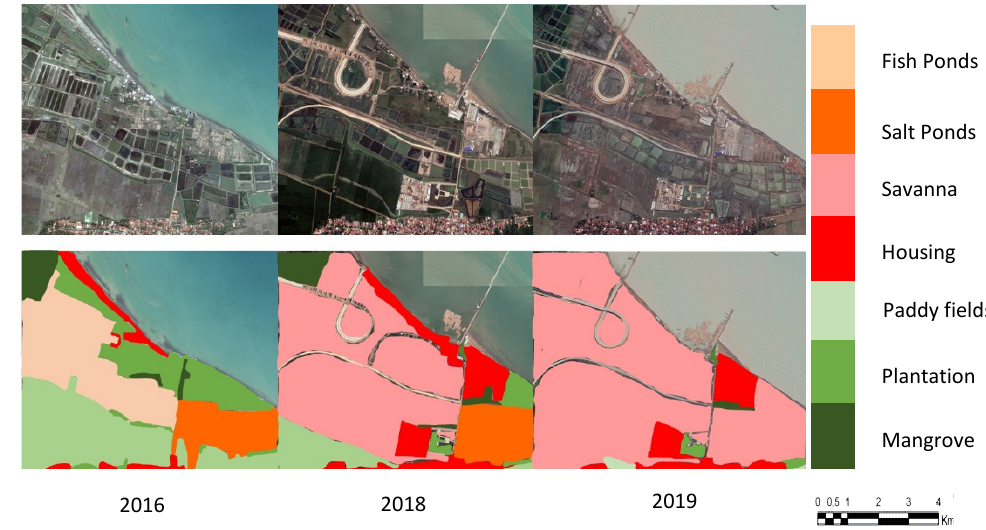
Figure 2. Land Use Changes in Patimban Area. Source: GIS analysis. By retracing the project development process of Patimban Seaport, three main stages of progress are evident (see Figure 3): (1) the planning stage, (2) the stage of land acquisition and conversion, and (3) the stage of construction.